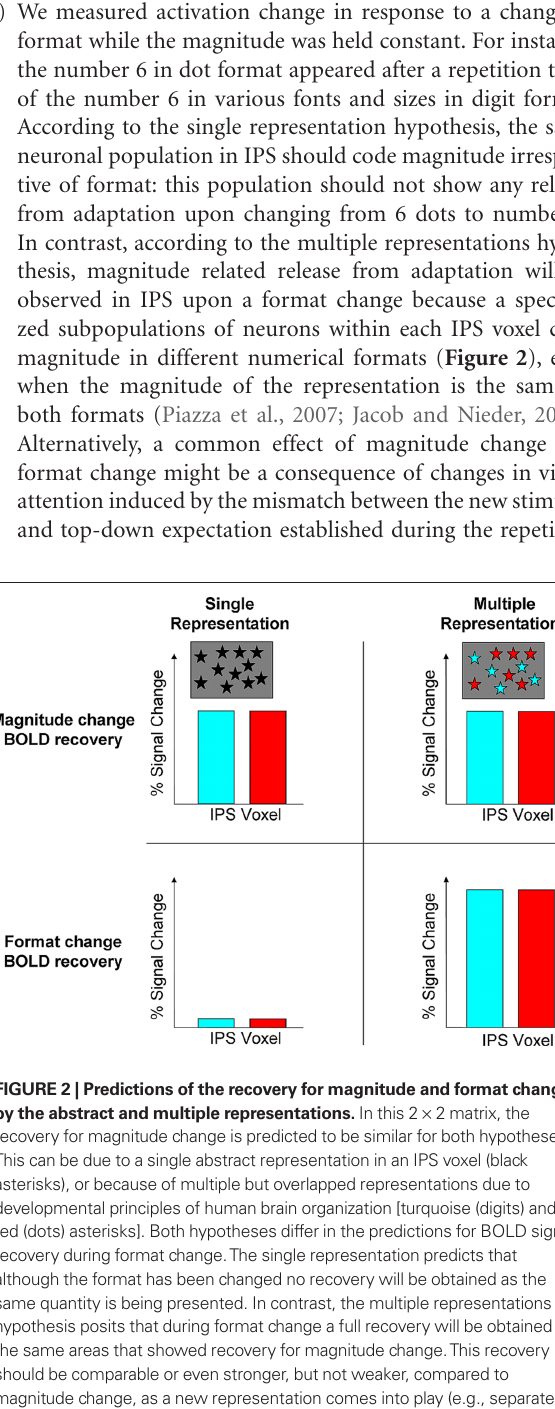
Figure 1 | An example of notation change, magnitude change and visuomotor change in the current paradigm for digit format. Similar conditions were used for dots. The current figure is only for illustrative purposes.